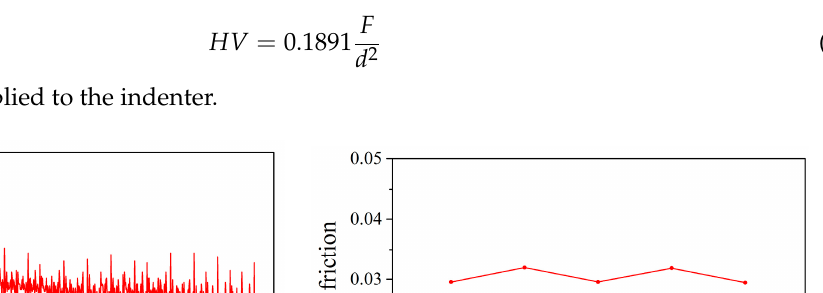
Figure 10. The curve of friction coefficient ( a ) and the relationship between the friction coefficient and load ( b ) All the simulation models needed to have been developed so that the high-temperature hardness simulation could be carried out. High-temperature hardness simulations at different temperatures were performed by importing different initial temperatures, and the design of the simulation is shown in Table 5. Table 5. Design of simulation for high-temperature hardness.